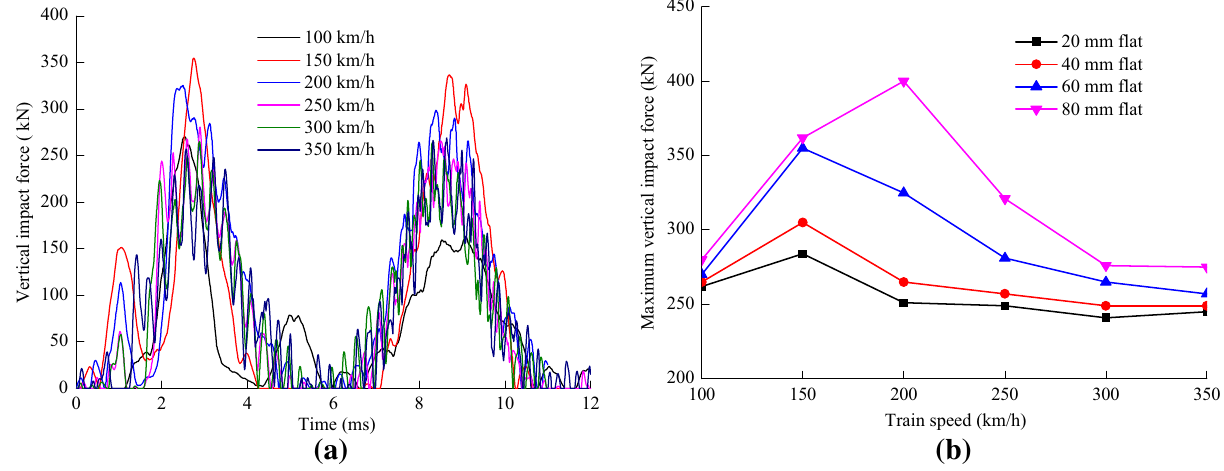
Fig. 6 Influence of train speed on the vertical wheel–rail impact response. a Vertical impact force–time curves. b Maximum vertical impact force as a function of train